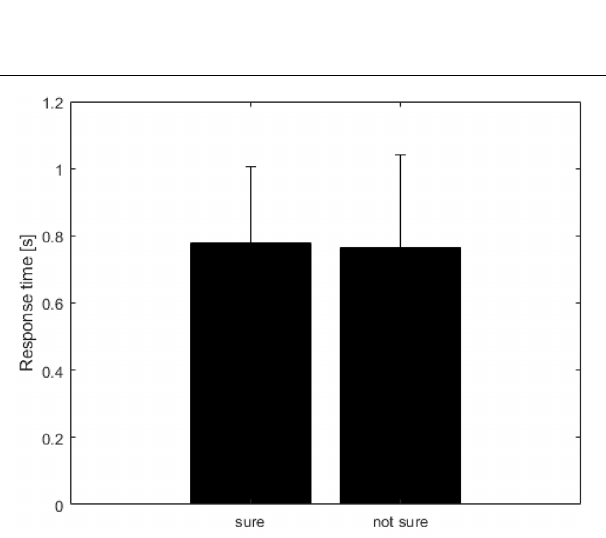
FIGURE 3 | The interval between human movement and robot movement. Unit is seconds (s). The mean value was calculated from six subjects selected for analysis. The error bar represents the standard deviation of the means of